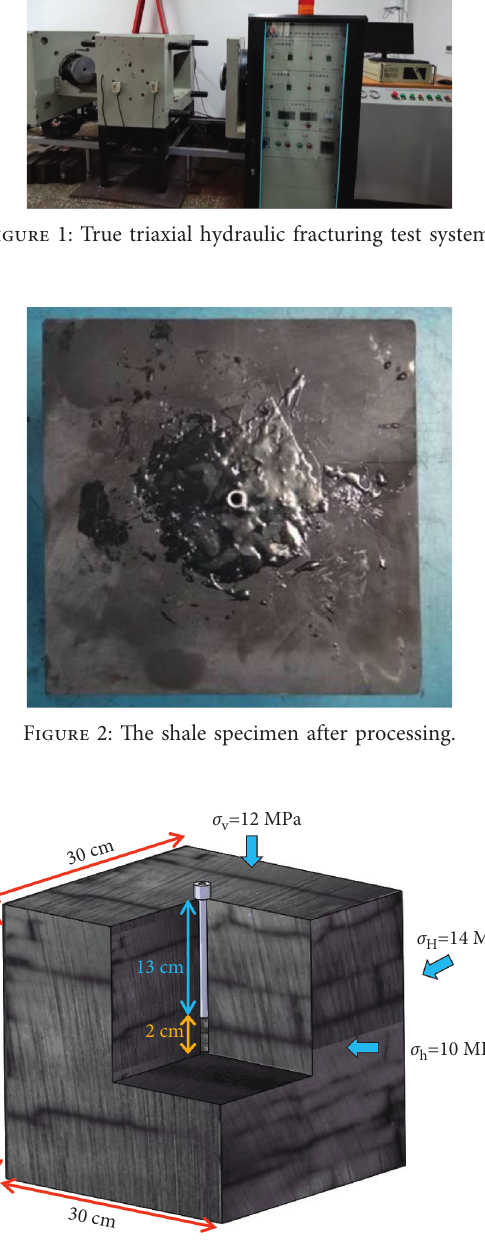
Figure 3: Three-dimensional (3D) graph of shale